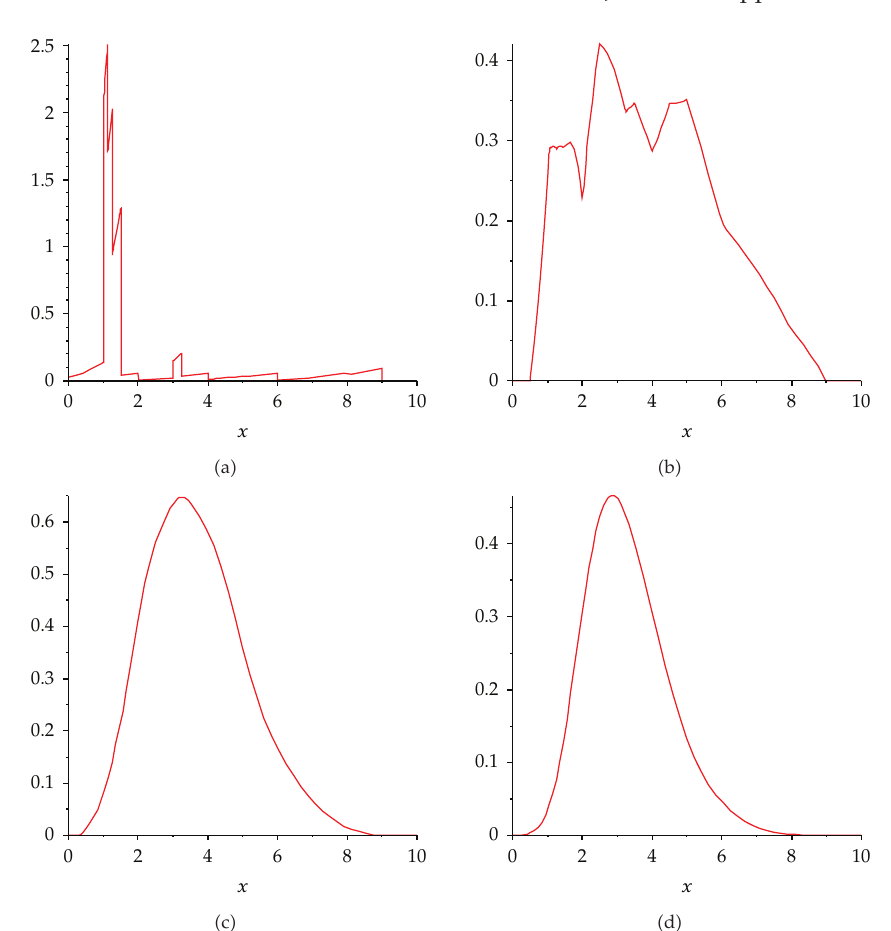
Figure 5: Experiment with the coupled model for the mobile solutions c im , with j (cid:9) 2 and j (cid:9) 4 iteration steps at time point t (cid:9) 8.